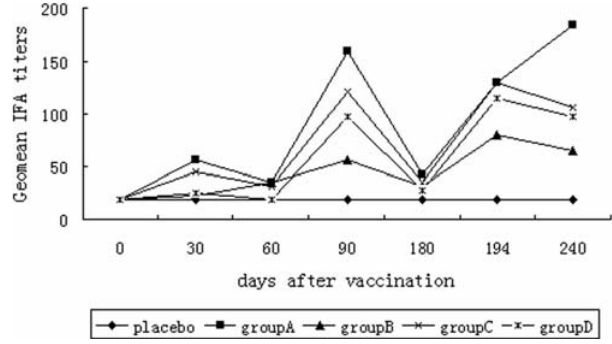
Figure 3. Kinetics of geometric mean values of the IFA titers to the parasite for the groups receiving 20 m g(A, & ), 50 m g(B, D ), 100 m g(C, 6 ) and 200 m g(D, *) of the test vaccine formulation and the placbo( ¤ ). The value was shown at the time-point days 0, 30, 60, 90,180,194 and 240.